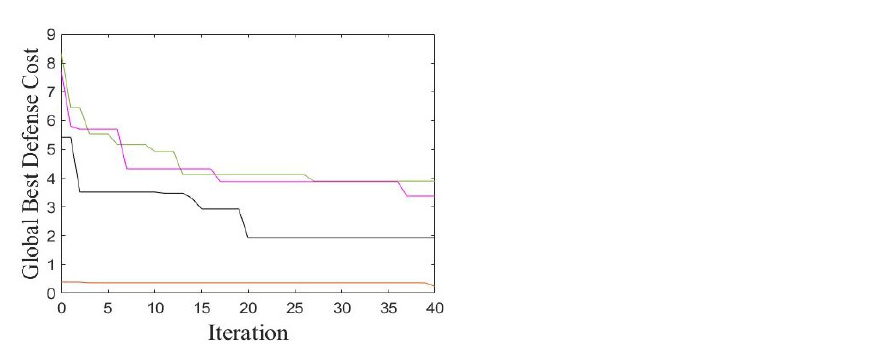
Figure 6. Convergence of defense cost against slant formation, black: ζ 1 , orange: ζ 2 , green: ζ 3 , purple: ζ 4 . The convergent values of ζ 1 , ζ 2 , ζ 3 and ζ 4 are 1.92, 0.24, 3.9, and 3.38,